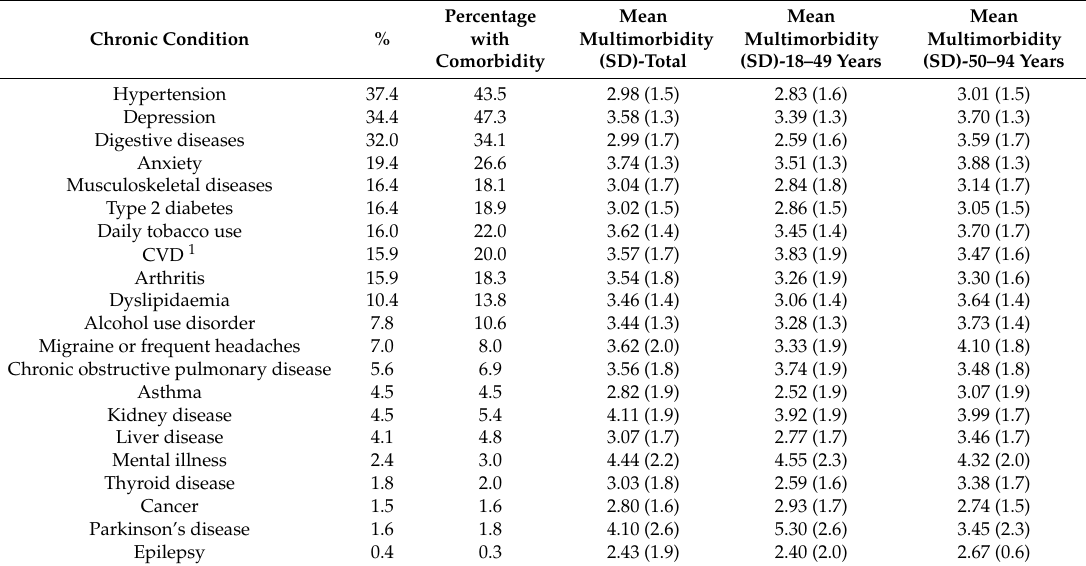
Table 1. Chronic condition morbidity pattern in the sample population.